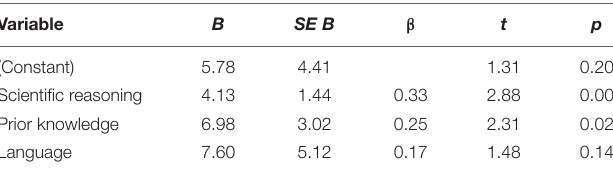
TABLE 9 | Regression analysis summary for scientific reasoning, prior knowledge, and language predicting observation